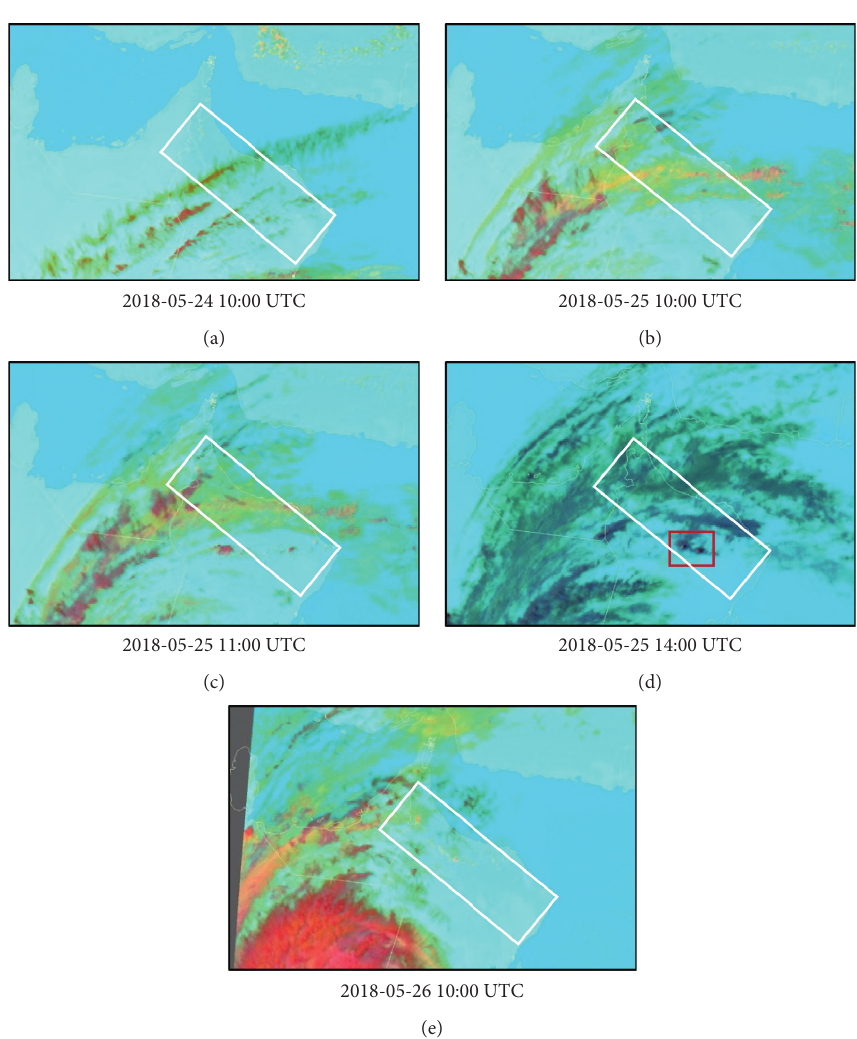
Figure 21: Sequence of day microphysics RGB images on 24 to 26 May 2018. The color scheme is useful to detect optically thick clouds with small ice particles on top (orange), thin clouds with small ice particles (light green), stratocumulus (violet), and water clouds (yellow and green).